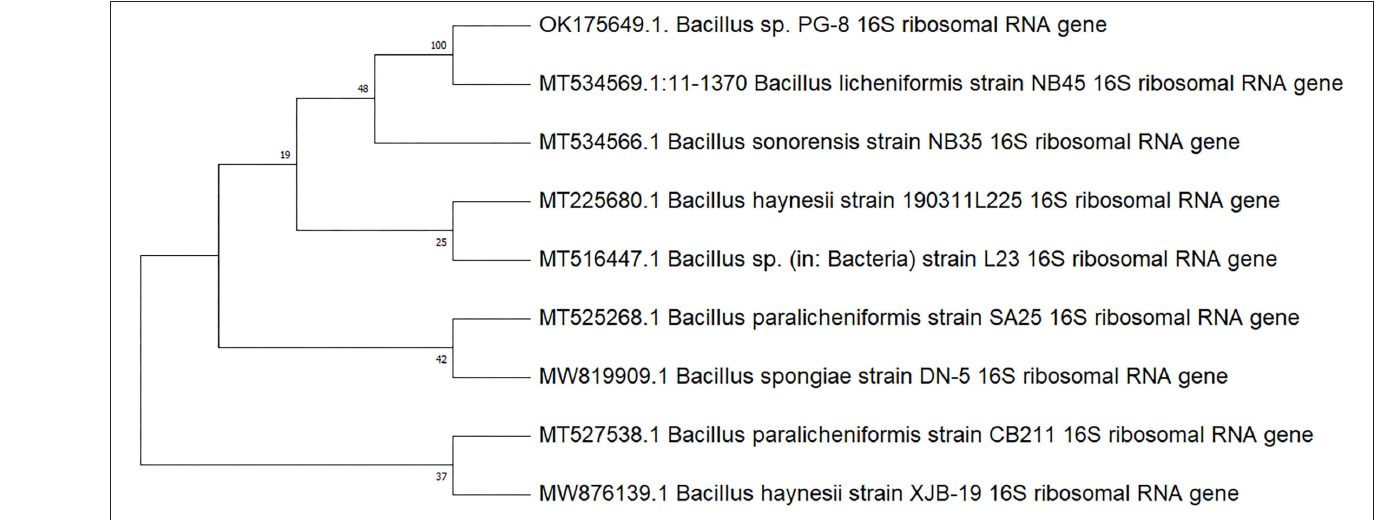
FIGURE 2 | Neighbor-joining phylogenetic tree of Bacillus sp. PG-8.